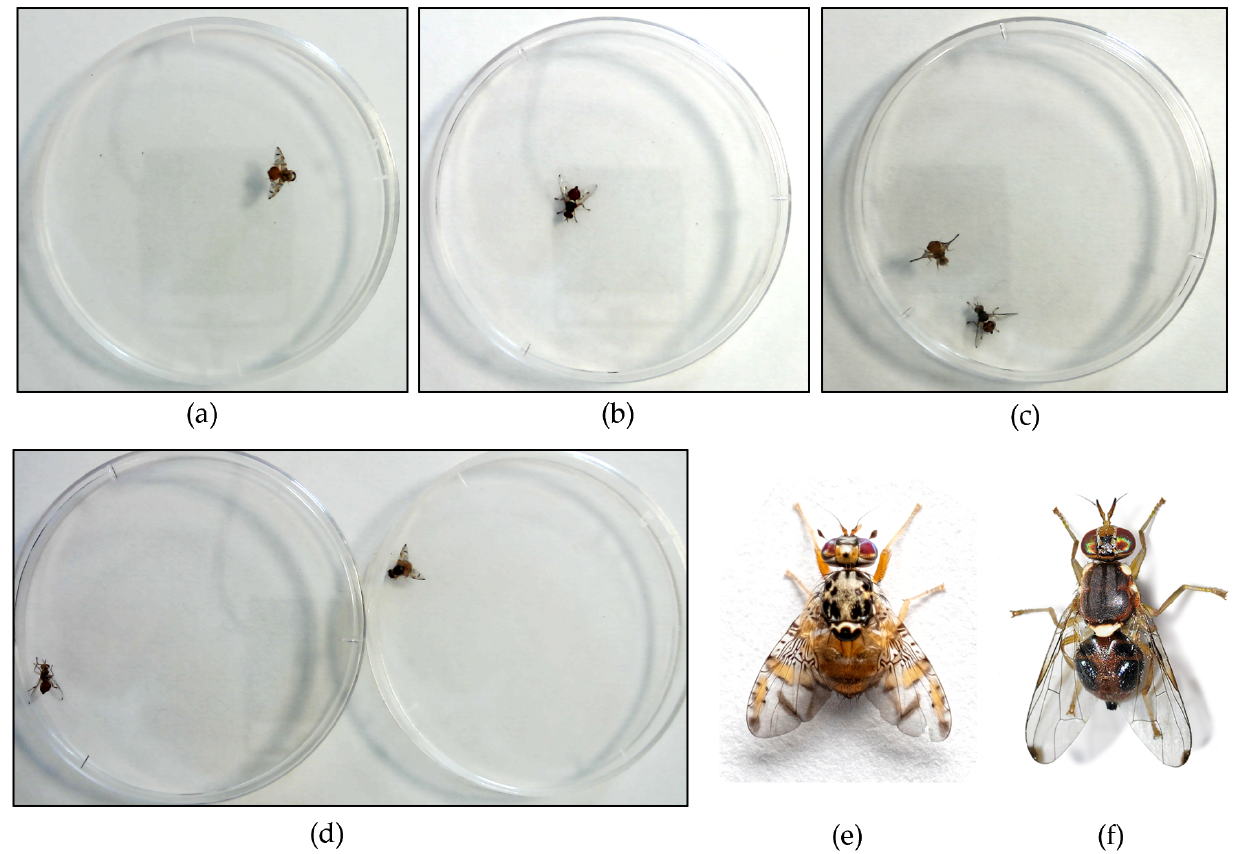
Figure 2. Dataset composition: ( a ) C. capitata adult fly in a petri dish; ( b ) B. oleae adult fly in a petri dish; ( c ) C. capitata and B. oleae in the same petri dish (performance set); ( d ) C. capitata and B. oleae in different petri dishes (performance set). Photographs of ( e ) C. capitata adult fly and ( f ) B. oleae adult fly .